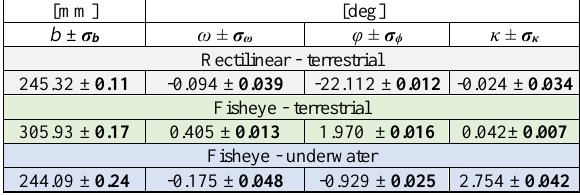
Table 2 . Asymmetric relative orientation of the right camera with respect to the left one for different configurations.